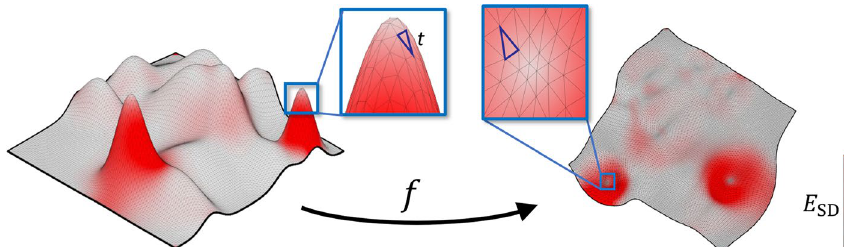
Fig. 5 Visualization of a simplicial map f with color-encoded local distortions E SD , defined by (5). We show how an individual triangle t is mapped under an affine component f t of the map